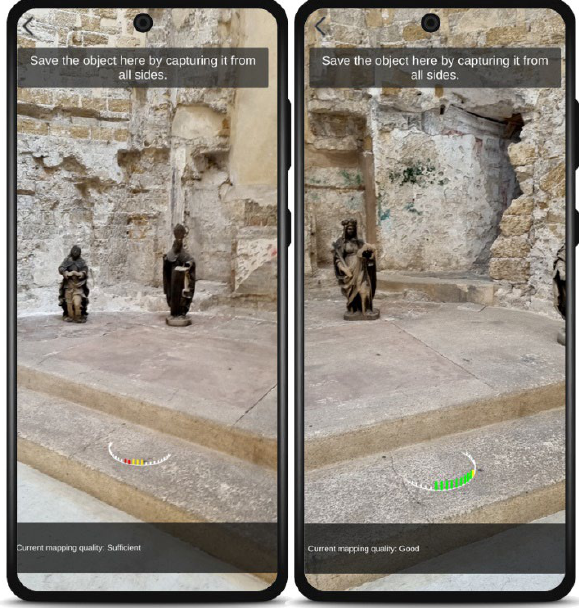
Figure 7. The anchor is positioned and the surrounding area Is surveyed.